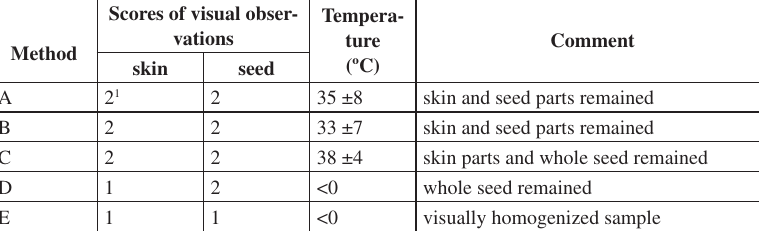
Table 2. Effect of processing method on sample homogenity and temperature Scores of visual obser- Method